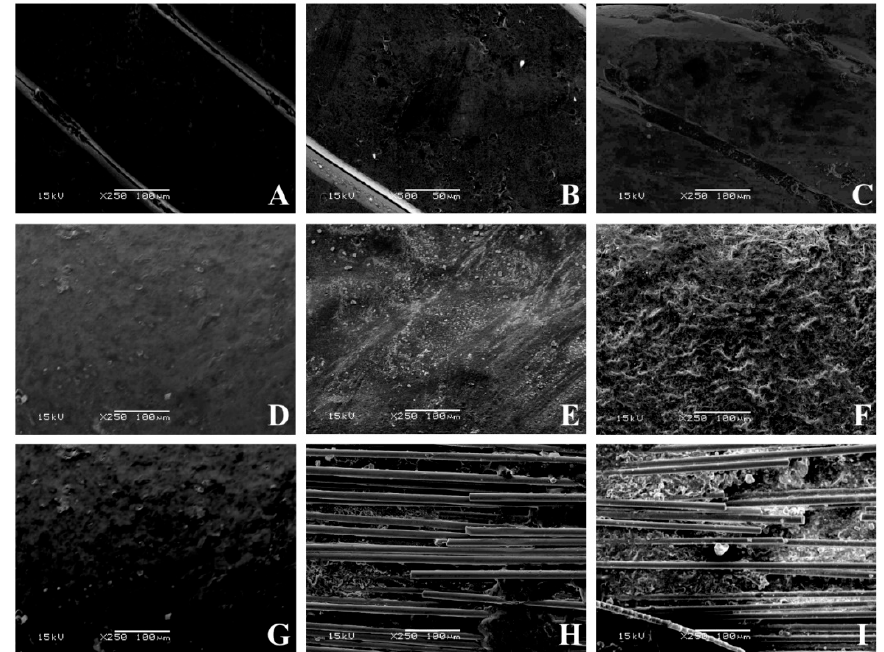
Figure 7. SEM pictures of various conditions tested at 250 × magnification. ( A ) Flat metallic wire not brushed ( B ) flat metallic wire brushed for 26 min, ( C ) flat metallic wire brushed for 60 min, ( D ) full-bonded FRC not brushed, ( E ) full-bonded FRC brushed for 26 min, ( F ) full-bonded FRC brushed for 60 min, ( G ) spot-bonded FRC not brushed, ( H ) full-bonded FRC brushed for 26 min, ( I ) full-bonded FRC brushed for 60 min.